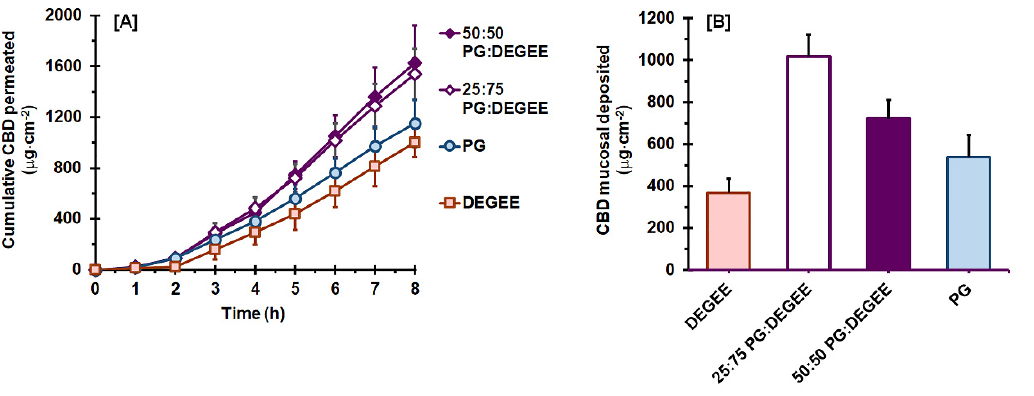
Figure 2. Ex vivo permeation profiles ( A ) and mucosal deposition amount ( B ) of CBD with the PG:DEGEE binary vehicle, when compared with neat DEGEE and PG (mean ± SD, n = 4). Table 3. Vehicle uptake capacity of mucosa and ex vivo permeation parameters of CBD with PG: DEGEE binary vehicles.